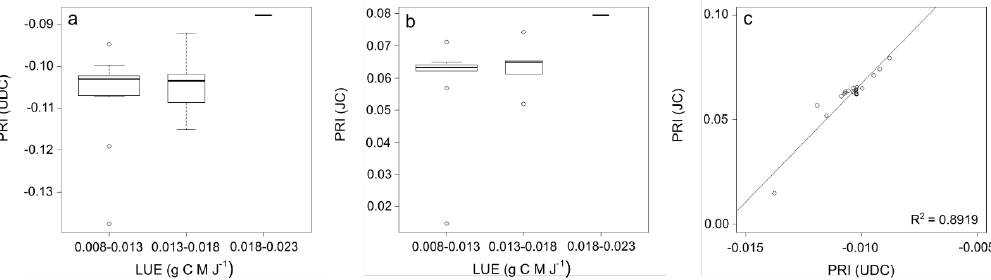
Figure 6. Box-and-whisker plot of 30 minutes EC-measured LUE and PRI observed by ( a ) UDC and ( b ) JC, with box width proportional to the number of observations. ( c ) UDC and JC measured PRI linear regression with regression line in solid.